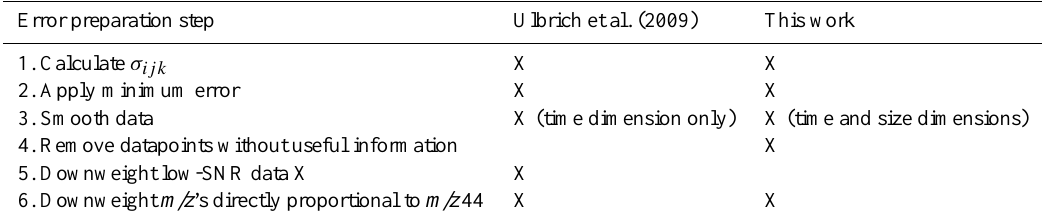
Table 2. Comparison of error preparation steps in Ulbrich et al. (2009) and this work. “X” marks the steps performed in each work. Error preparation step Ulbrich et al. (2009) This